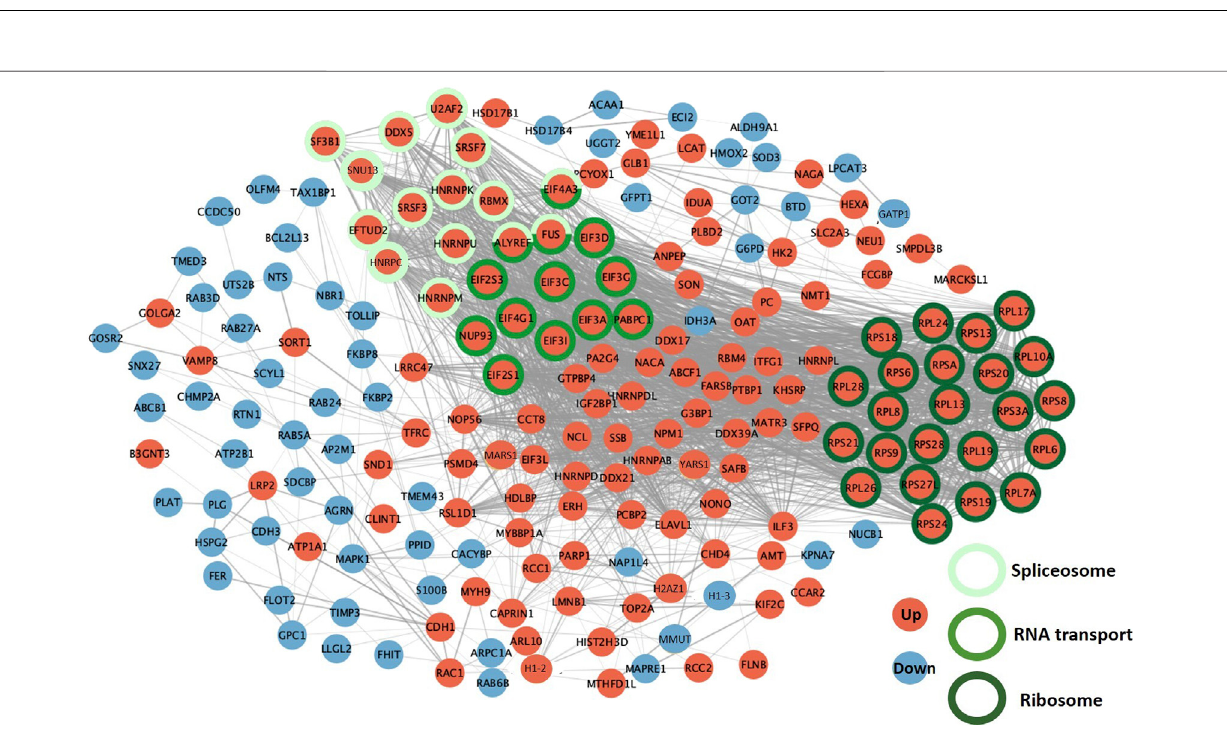
Frontiers in Cell and Developmental Biology |